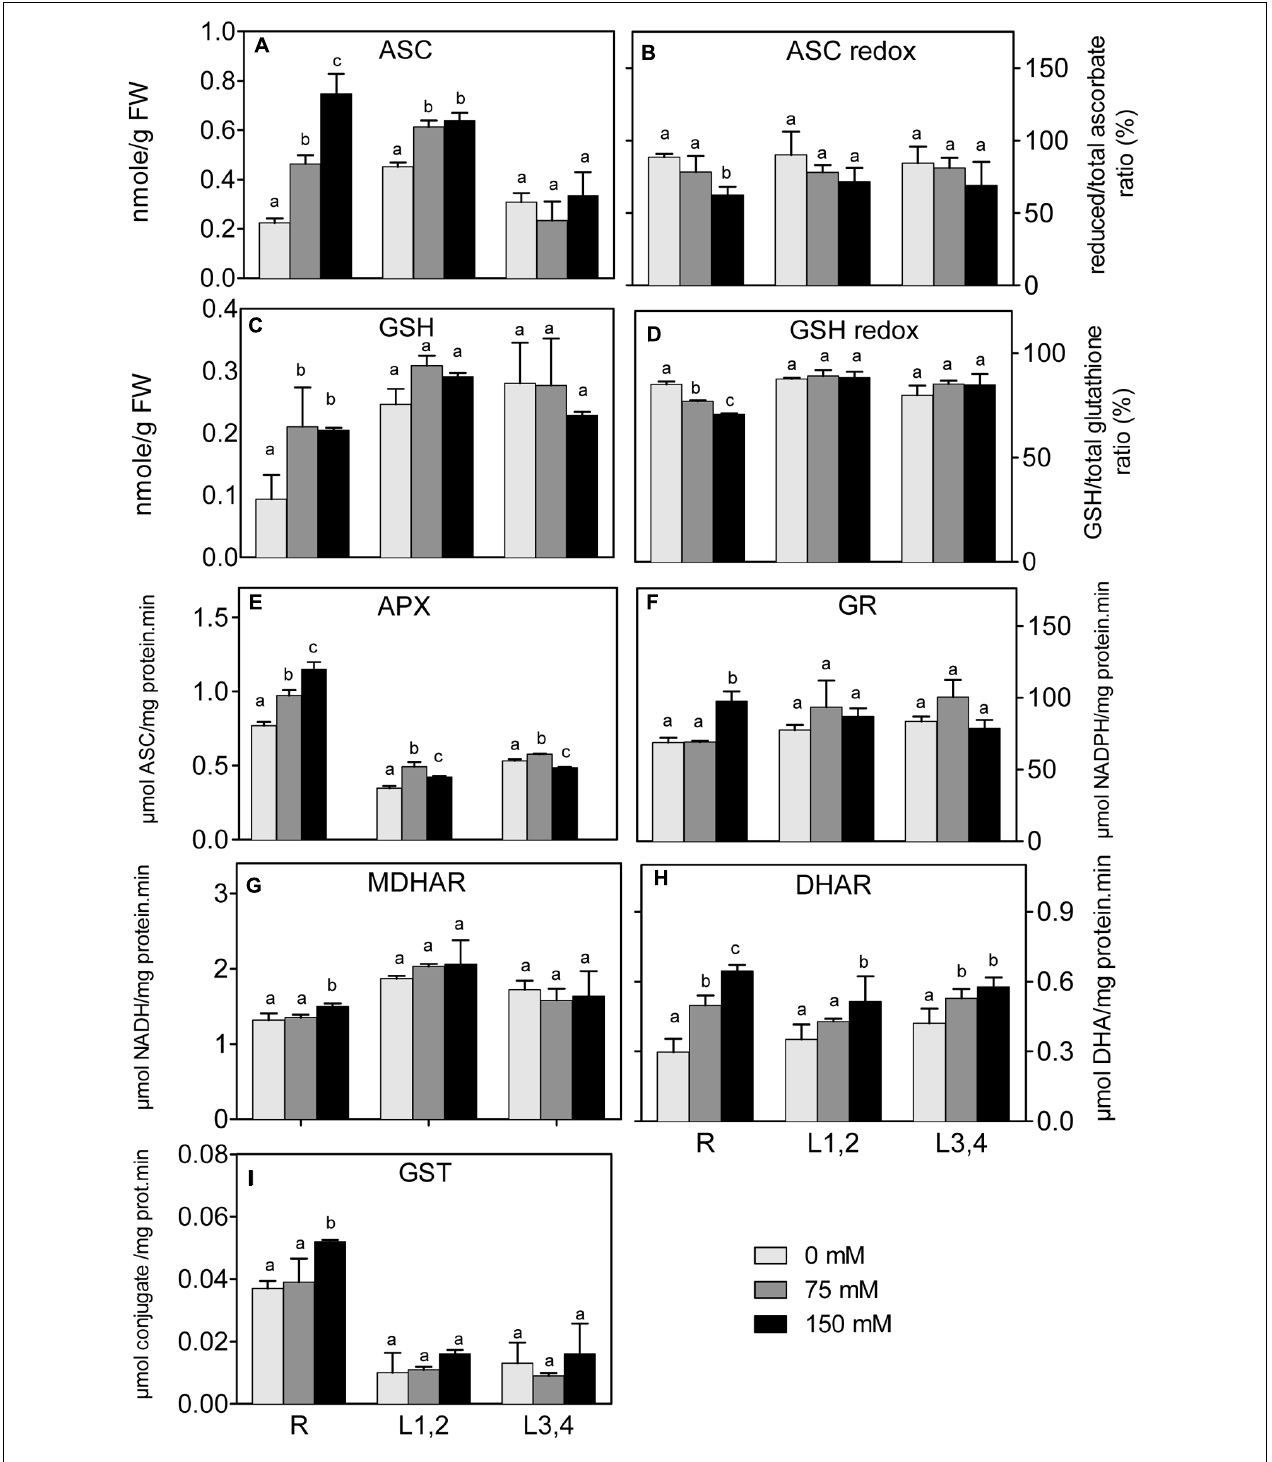
FIGURE 6 | Effect of different salinity levels on reduced ascorbic acid (ASC, A), ascorbate redox status (reduced/total ascorbate, B), reduced glutathione (GSH, C), glutathione redox status (reduced/total glutathione ratio, D), ascorbate peroxidase (APX, E), glutathione reductase (GR, F), monodehydroascorbate reductase (MDHAR, G), dehydroascorbate reductase (DHAR, H), and glutathione- S -transferase (GST, I) activities of root (R), mature leaf pair (L1,2), and young leaf pair (L3,4) of 3 weeks old maize seedlings. Values are means of at least three replicates and significant differences between means, as determined by Duncan test ( P < 0.05), are indicated by different letters.